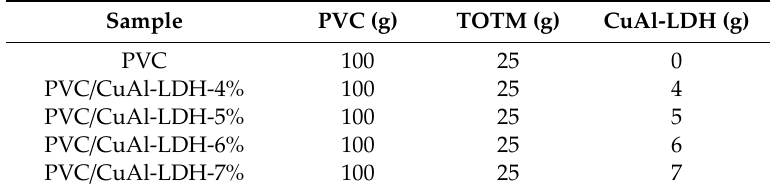
Table 1. Sample compositions. PVC = polyvinyl chloride; LDH = layered double hydroxide.